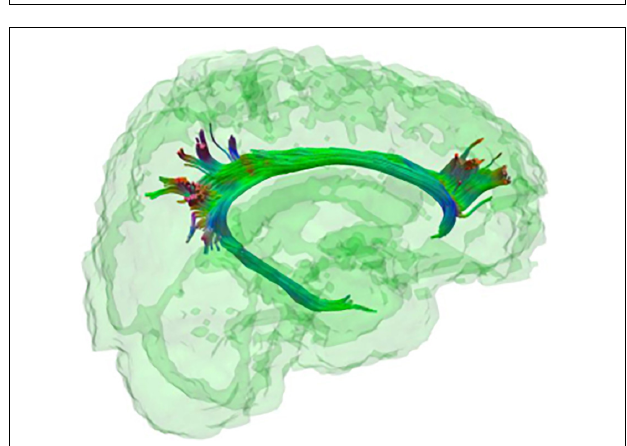
FIGURE 2 | Main long association fibres affected in Down syndrome. Tractography representation of the main long association fibres affected in Down syndrome. SLF, Superior longitudinal fasciculus; IFOF, Inferior fronto-occipital fasciculus; UF, Uncinate fasciculus; ILF, inferior longitudinal fasciculus.